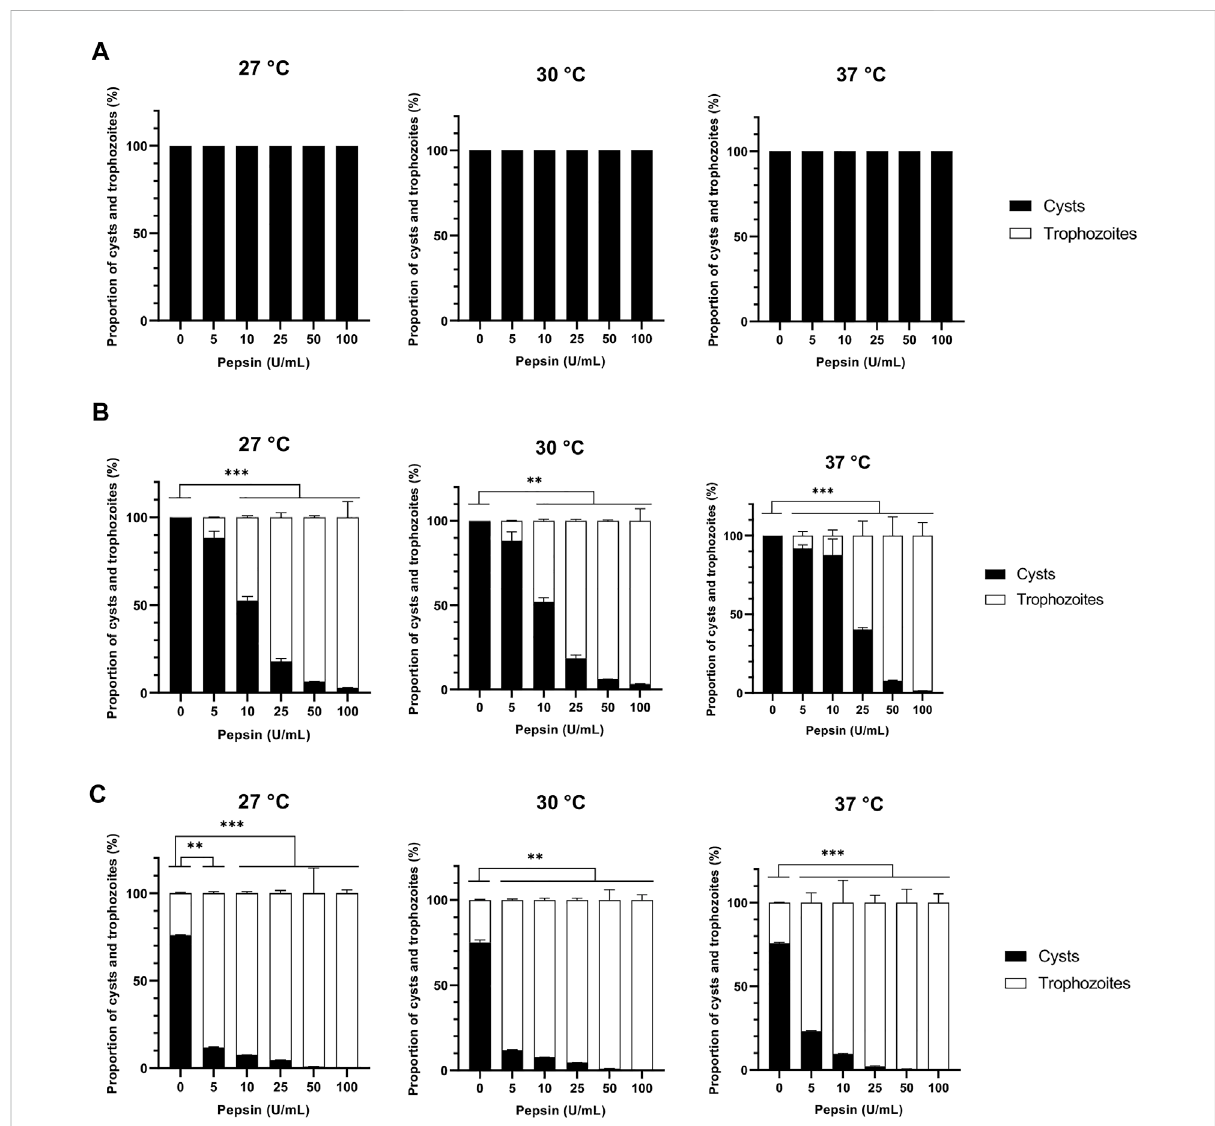
FIGURE 3 Effect ofpepsin on Acanthamoebacastellanii excystment.Proportionsof A.castellanii trophozoitesandcysts observedfollowing24 h (A) ,48 h (B) and 72 h (C) of pepsin treatment at 27, 30 and 37 ° C as a function of enzyme concentration. The results correspond to the mean of four independent experiments ±SD.